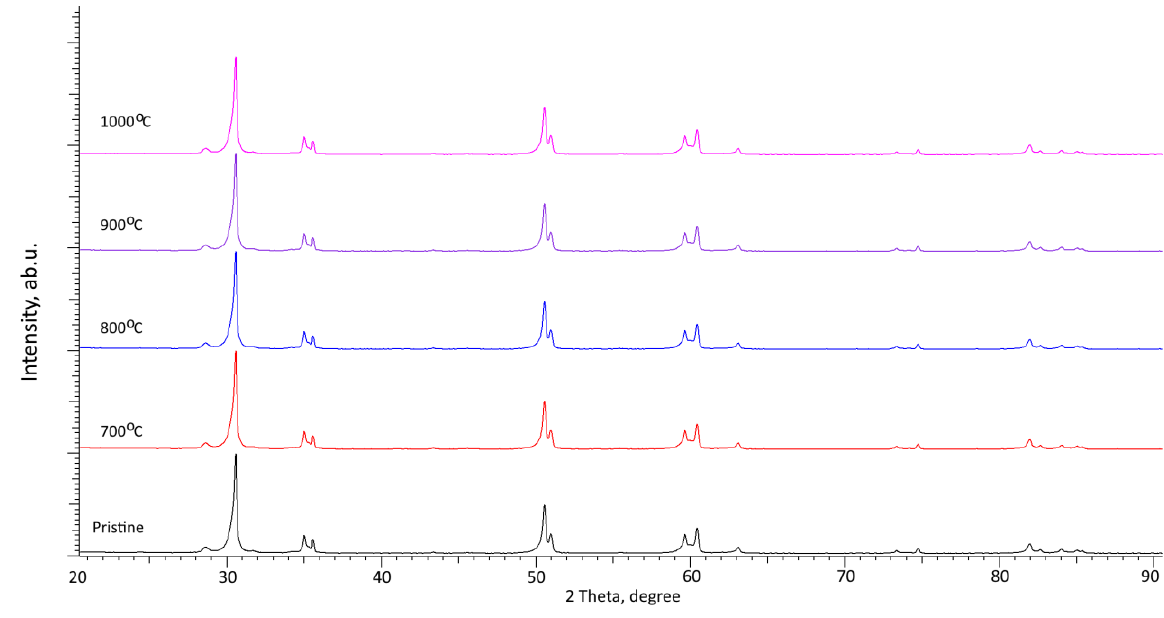
Figure 12. X-ray diffraction patterns of the studied samples of ZrO 2 ceramics depending on the annealing temperature.